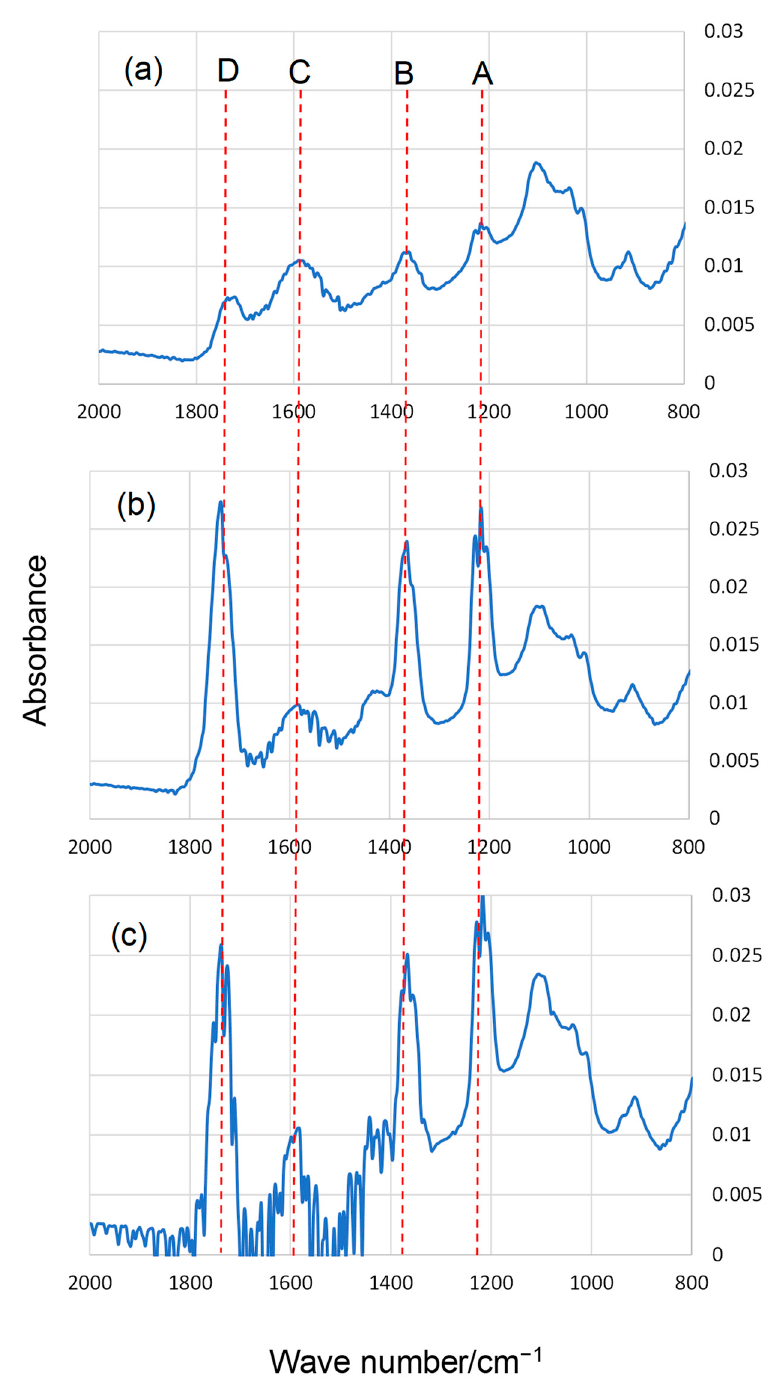
Figure 4. Typical FT-IR spectra of HA ( a ) before UV irradiation, ( b ) after 6 h of UV irradiation, and ( c ) after 10 h of UV irradiation (see text for detailed assignments of peaks A–D).